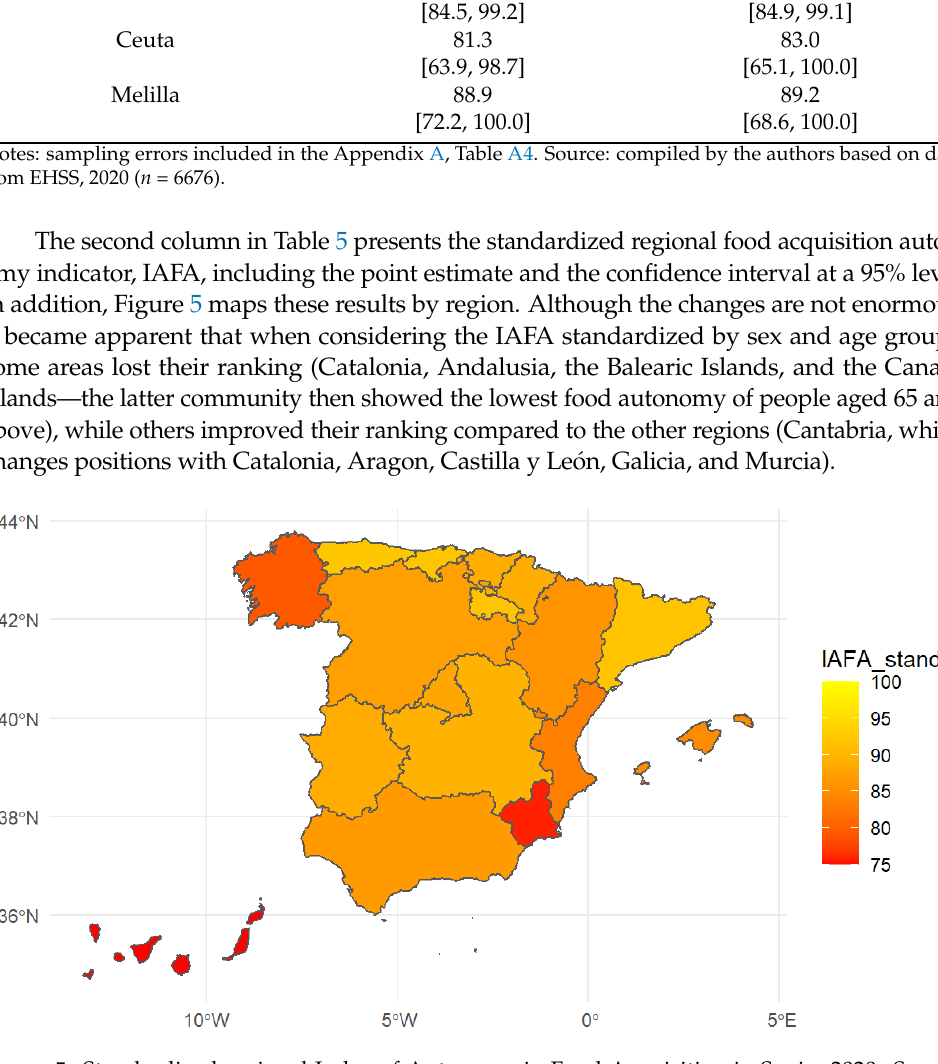
Table 6. IAFA, standardized IAFA and 95% confidence interval (in parentheses below) by monthly income level.